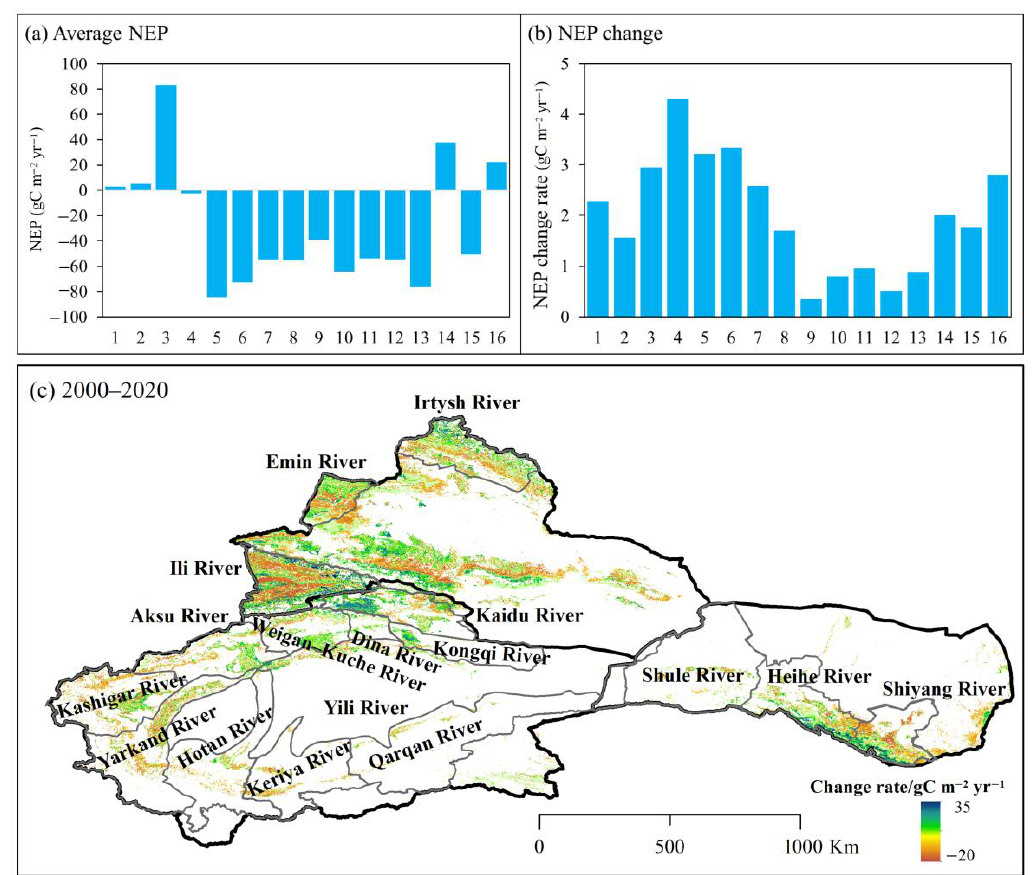
Figure 4. NEP distribution and trends in NWC’ basins during 2000–2020. ( a ) Annual average NEP; ( b , c ) spatial variations of NEP in different basins. Note: (1) Irtysh River basin, (2) Emin River basin,